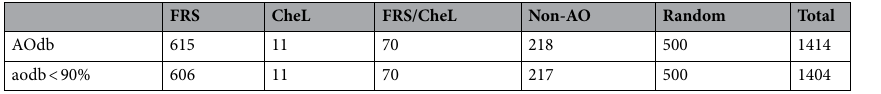
Table 1. Overview over the benchmark dataset. FRS, CHEL, FRS/CHEL and NON-AO are all experimentally- validated peptides obtained from various papers. RANDOM consists of peptides derived from the UniProt 46 database, with lengths between 2–30 amino acids. AODB < 90% is the number of peptides after removal of sequences, so no pair has more than 90% identity. FRS free radical scavenger, CHEL chelator, FRS/CHEL both FRS and chelator, NON-AO non-antioxidant.